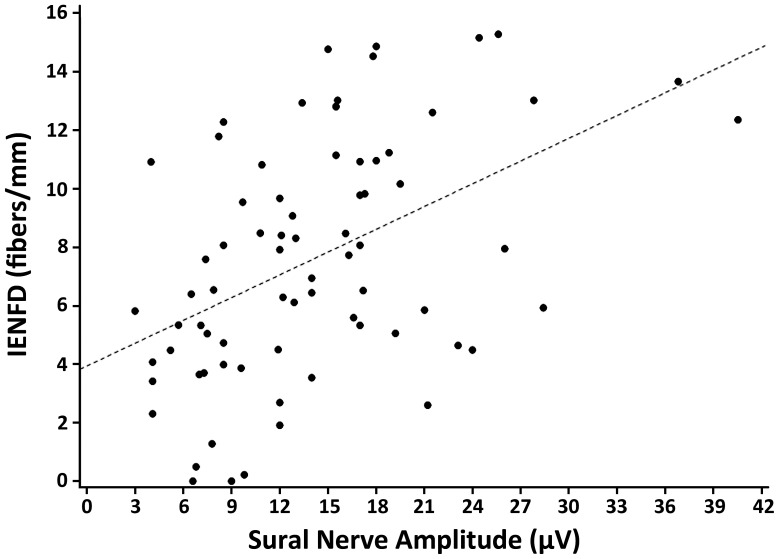
Shows the linear regression model for IENFD as a function of the sural sensory nerve action potential amplitude. (R2 = 0.22, p<0.001).